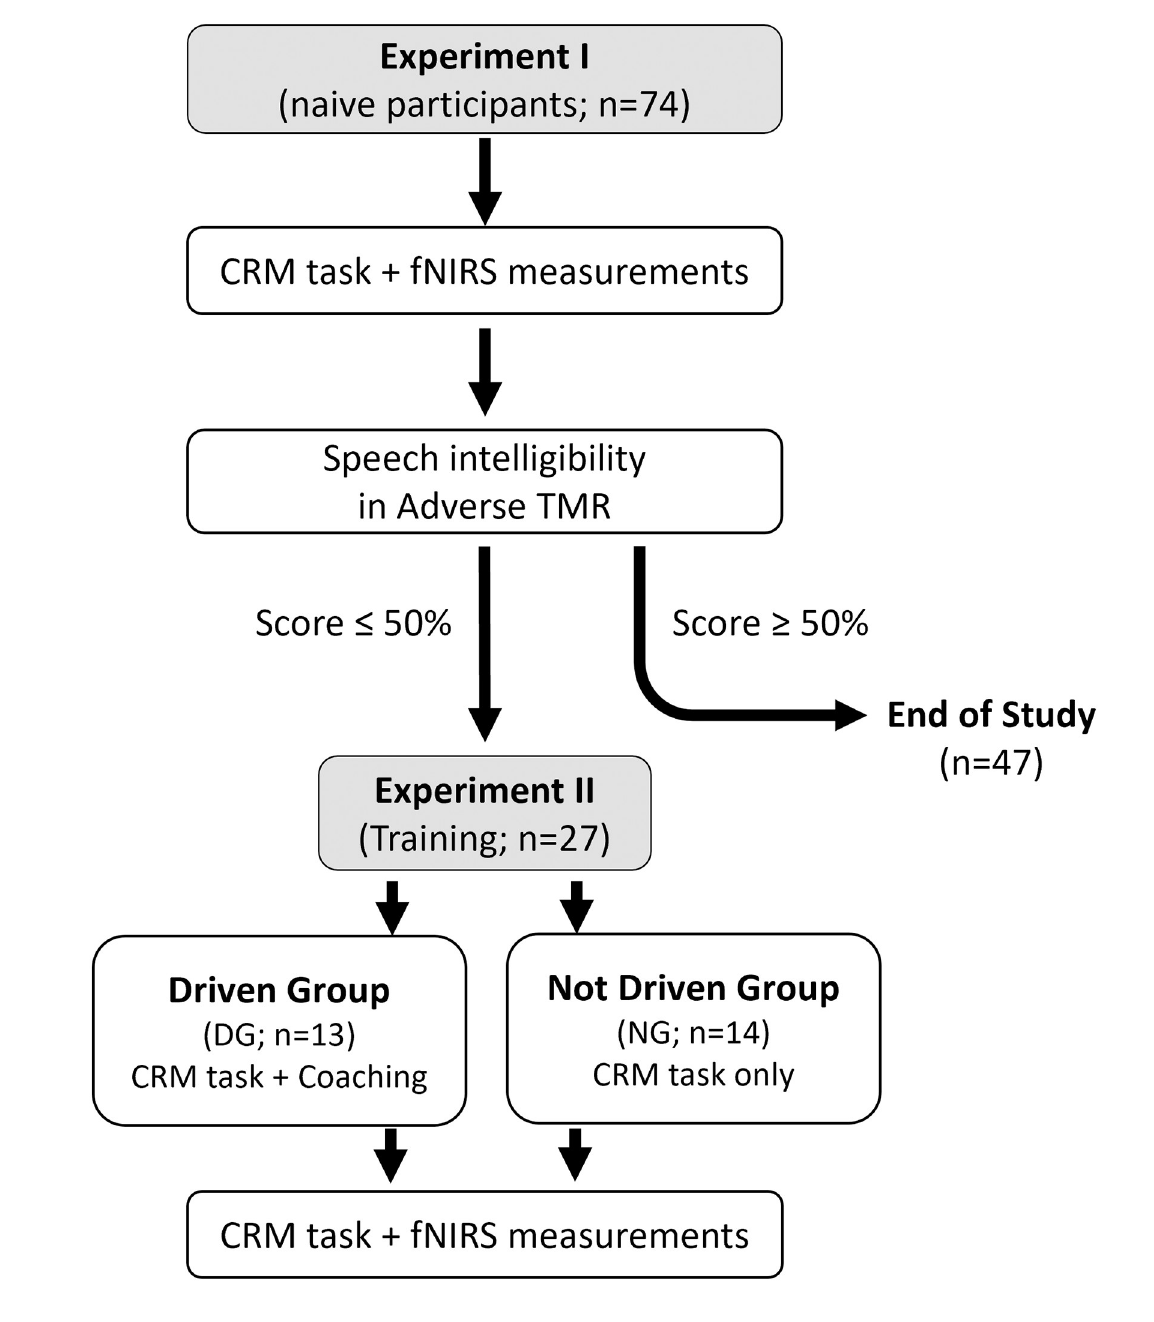
Fig 6. Schematic of the experimental design. The two experiments are illustrated: Experiment I and Experiment II. For each experiment the number of participants and the experimental protocol are specified. The Experiment II also specifies the criterion for selecting the participants, the division into sub-groups and the training strategy